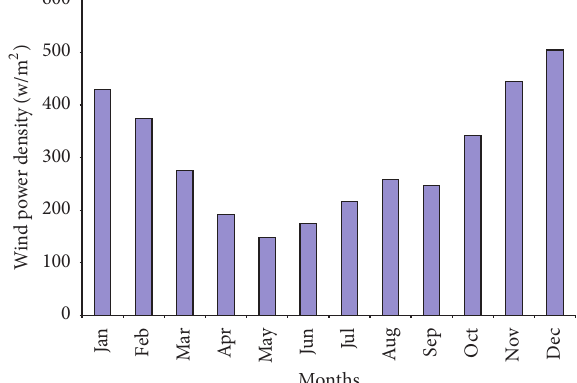
Figure 5: Values of monthly mean wind power density for the period 1980–2009 in the ECS calculated by the Weibull distribution, unit: w/m 2